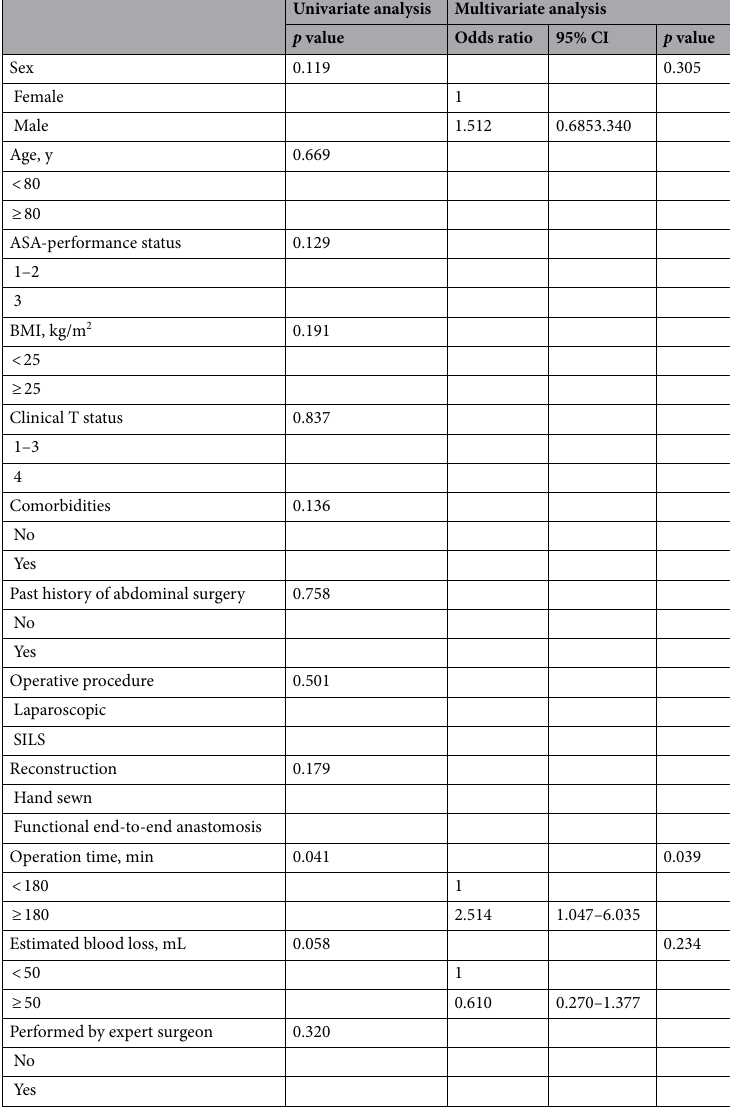
Table 7. Clinical factors predicting postoperative complications of colorectal cancer patients with synchronous distant metastases. HR hazard ratio, CI confidence interval, ASA American Society of Anesthesiologists. A Cox proportional hazards model was used to identify the independent risk factors for postoperative